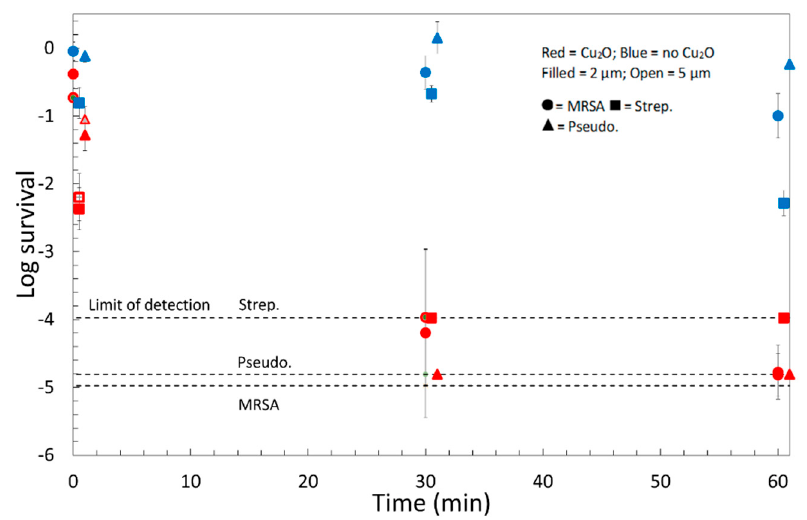
Figure 3. Time course of bacterial survival on polypropylene textiles with and without Cu 2 O-treatment. Note that the vertical axis is on a log 10 scale. Data are shown for two particle sizes: 2 µm (filled symbols) and 5 µm (empty symbols). Circles are P. aeruginosa : squares are S. pneumoniae, and triangles are MRSA. Each data point represents the mean of the log of three independent measurements, and the error bars represent the 95% confidence interval for each condition. Data points for different organisms at the same time have been shifted horizontally for clarity. Data is tabulated in Tables S6–S8. The CFUs are reduced by 99.9% after 30 min for each organism on both the 2 µm and 5 µm samples.